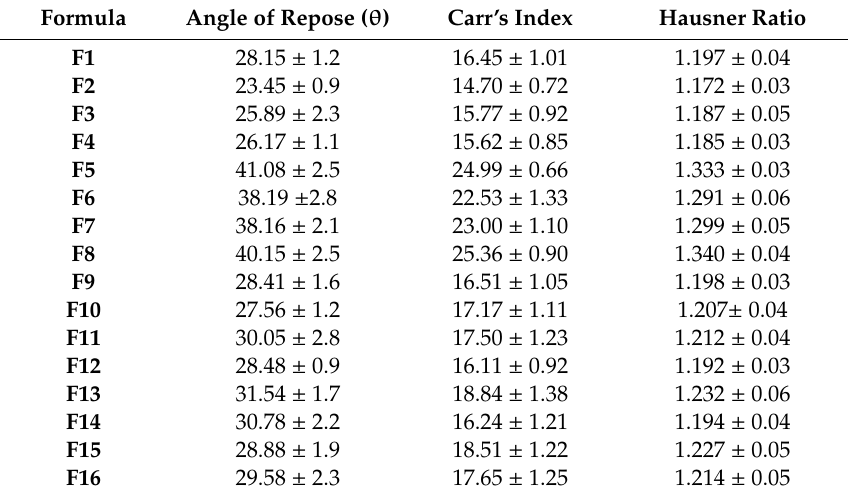
Table 5. Micromeritics of the prepared FEX